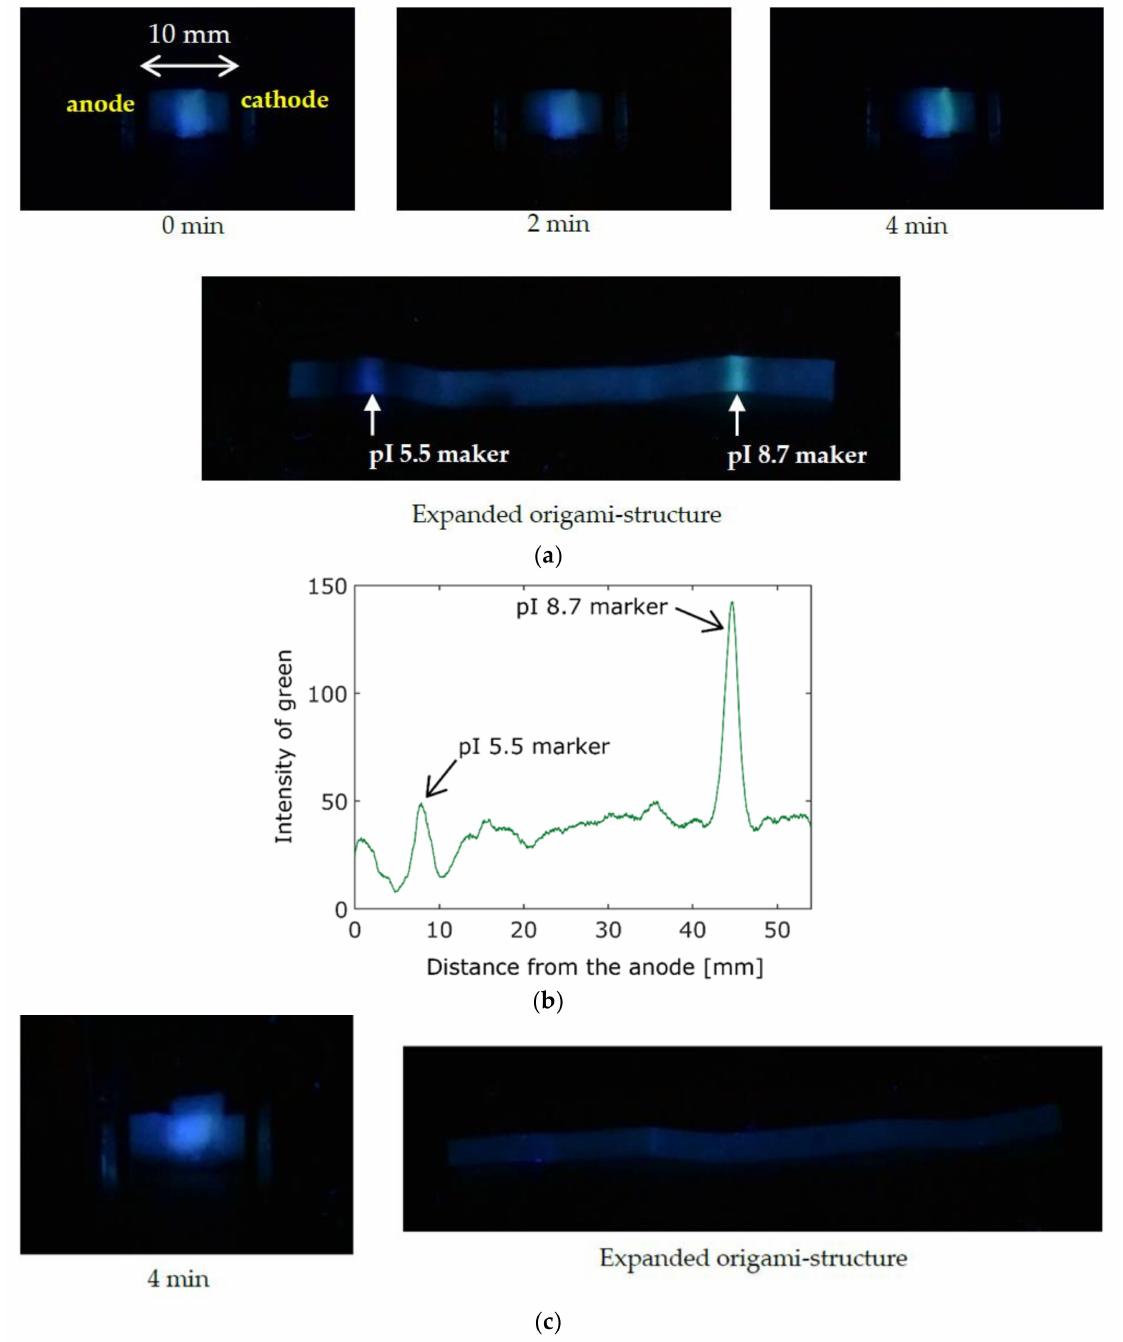
Figure 3. Fluorescent images of pI 5.5 and pI 8.7 markers during electrophoresis. ( a ) Time-lapse images during electrophoresis at 5 V. ( b ) Intensity distribution of the green color along the extended paper. ( c ) Control experiment in the absence of applied voltage (0